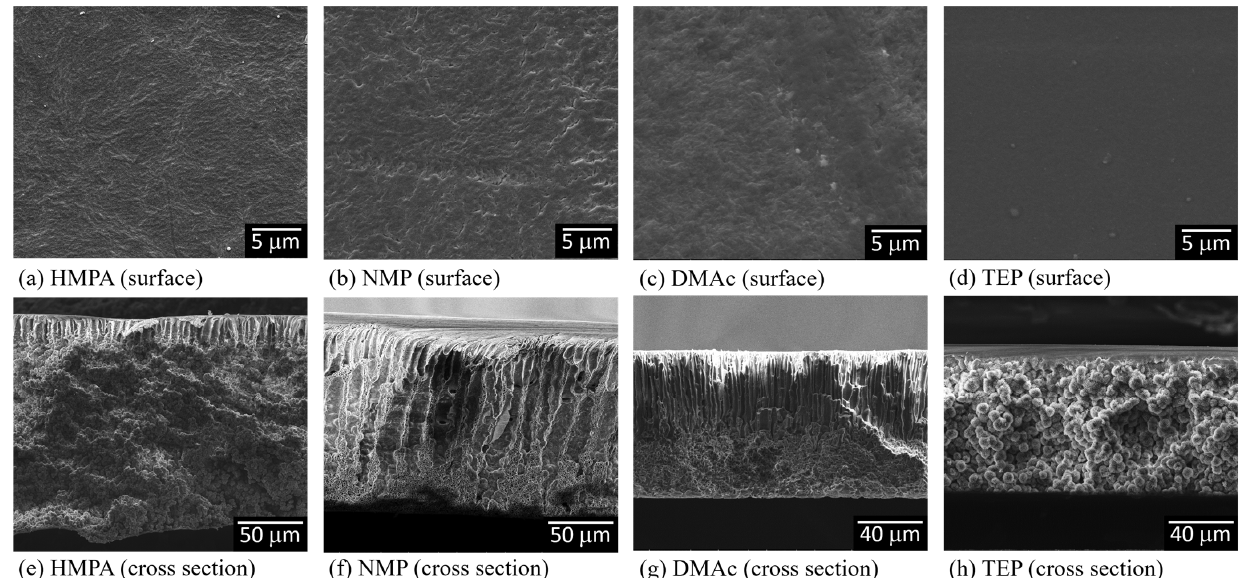
Figure 4. SEM images of the surfaces and cross-sections of PVDF membranes prepared with nonsolvent-induced phase separation, with HMPA, NMP, DMAc or TEP used as the solvent to dissolve PVDF.